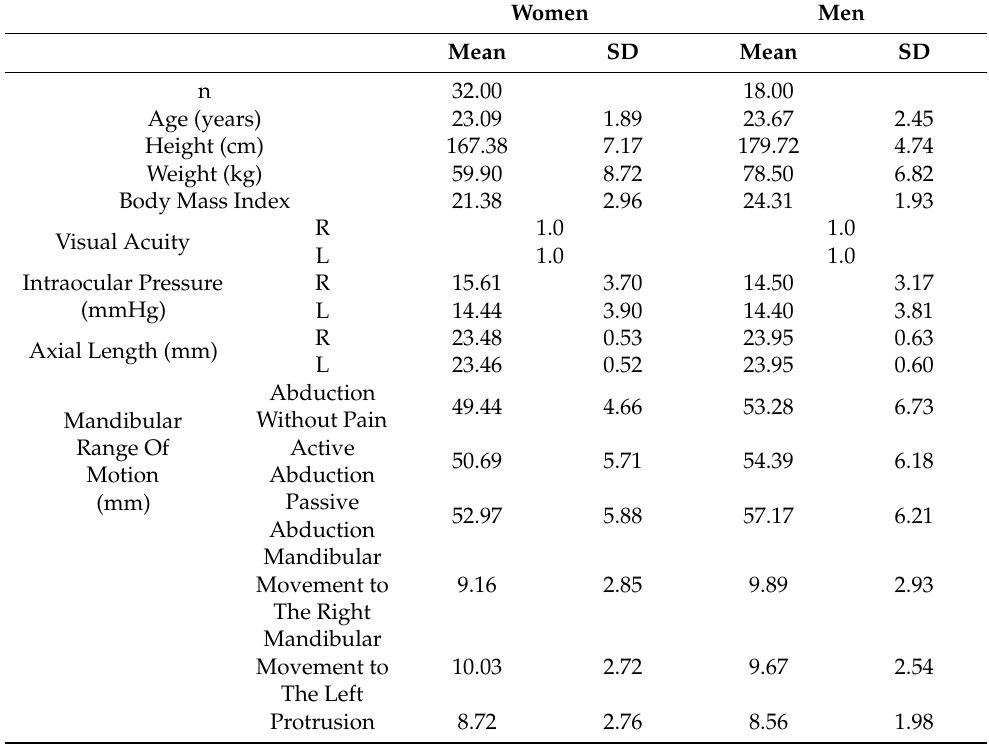
R—right site; L—left